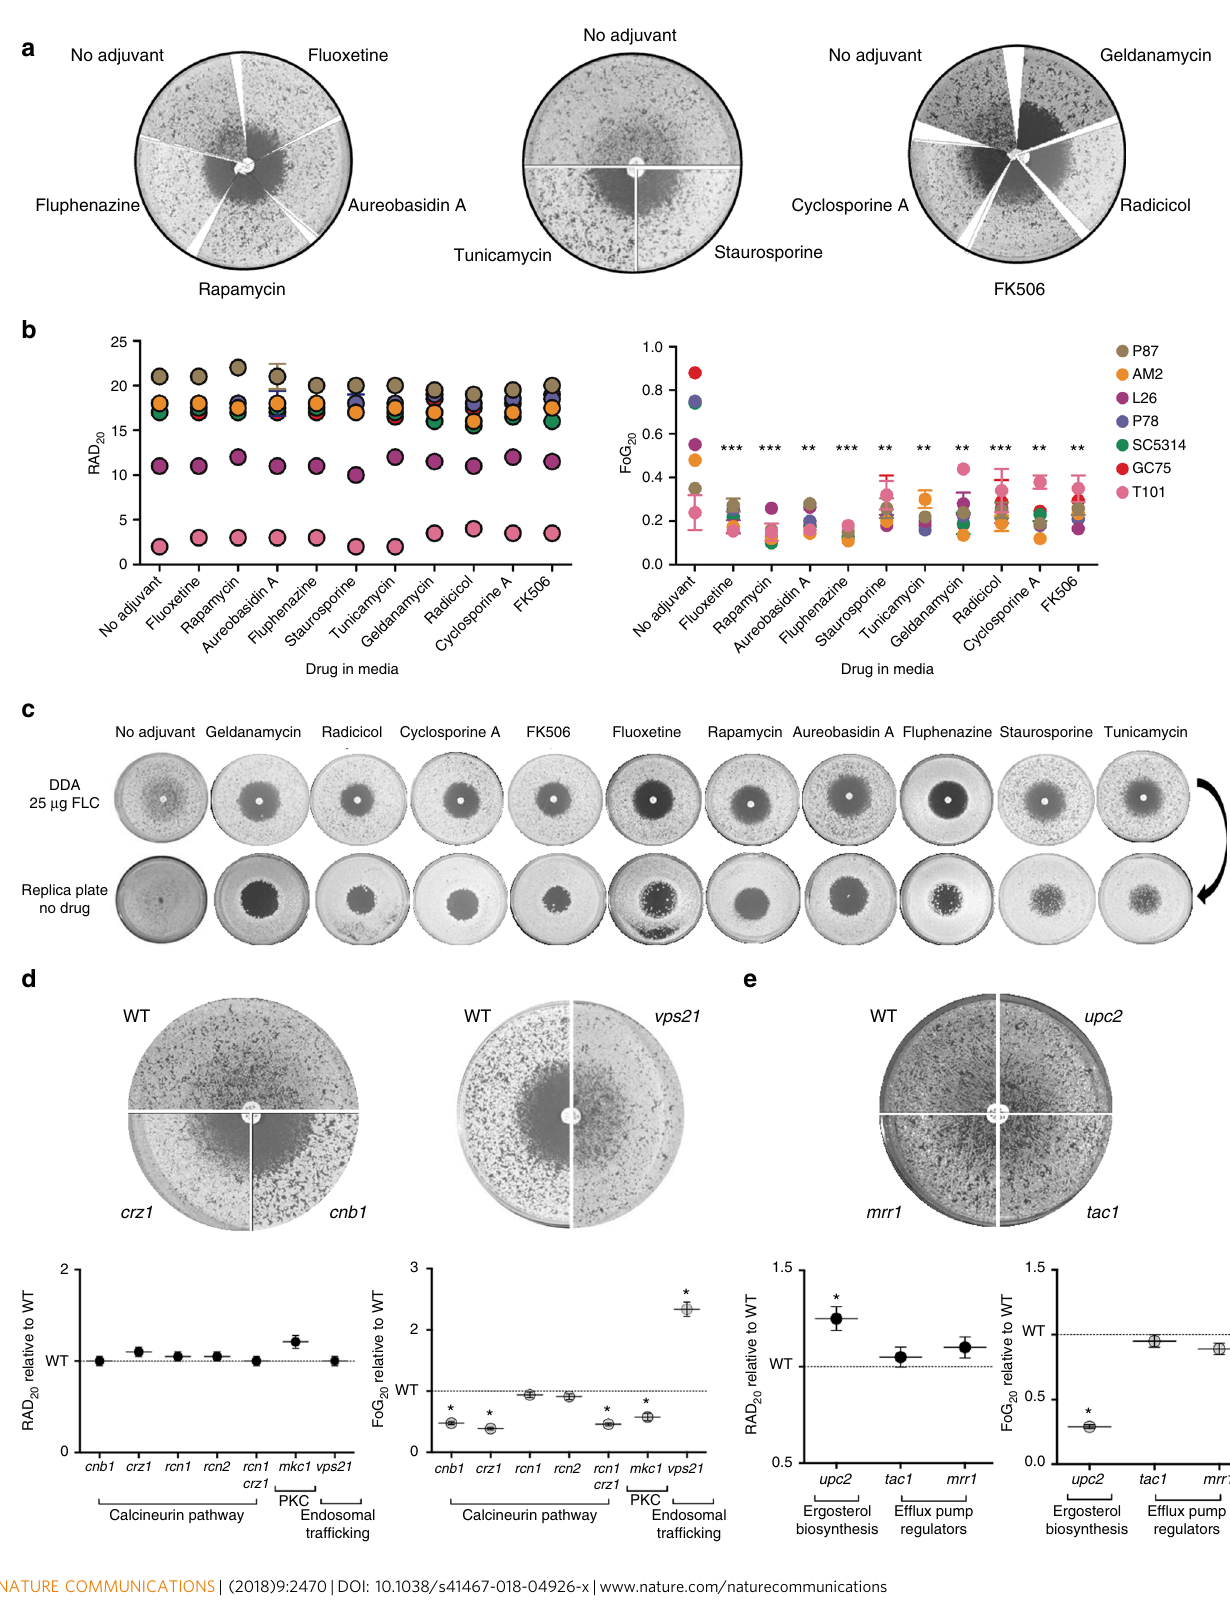
Fig. 8, detailed information on genes tested in Supplementary Notes 2 – 4 and Supplementary Tables 2 and 3). UPC2 , which encodes a major transcriptional regulator of ergosterol biosynthesis 54 , affected both RAD and FoG levels signi fi cantly, while two regulators of ef fl ux pump transcription had no